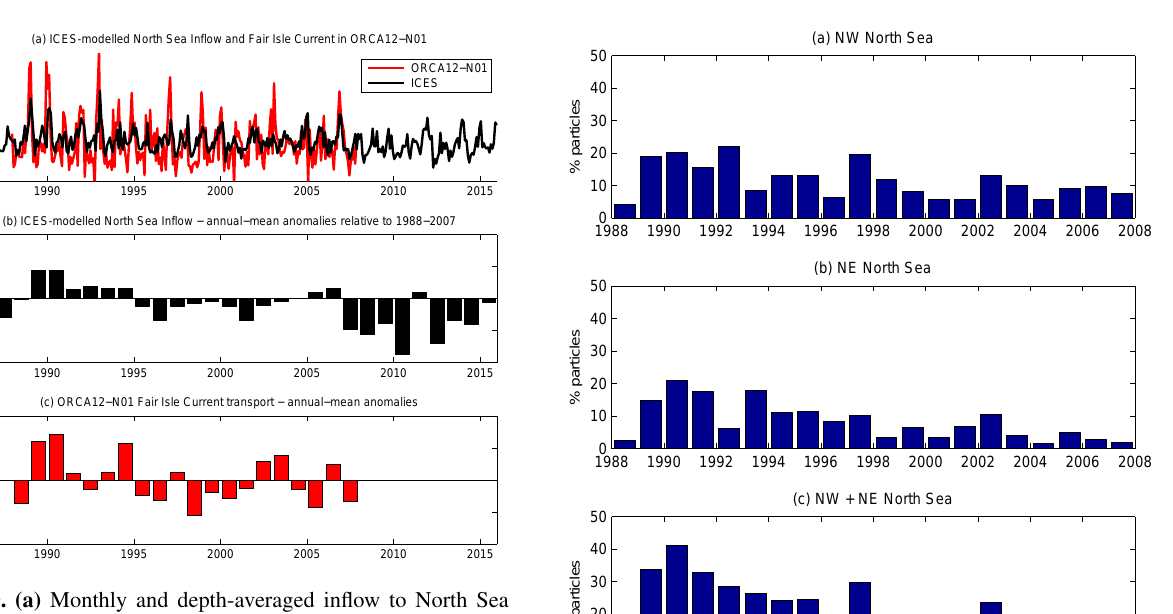
Figure 10. (a) Monthly and depth-averaged inflow to North Sea (source: ICES Report on Ocean Climate (thick line)), and 30- day running average of 5-day averaged Fair Isle Current transport in ORCA12-N01 (thin line); (b) annual-mean transport anomalies from ICES transport estimates of Atlantic inflow (relative to 1988– 2007 mean); (c) annual-mean transport anomalies of Fair Isle Cur- rent transport in ORC12-N01.